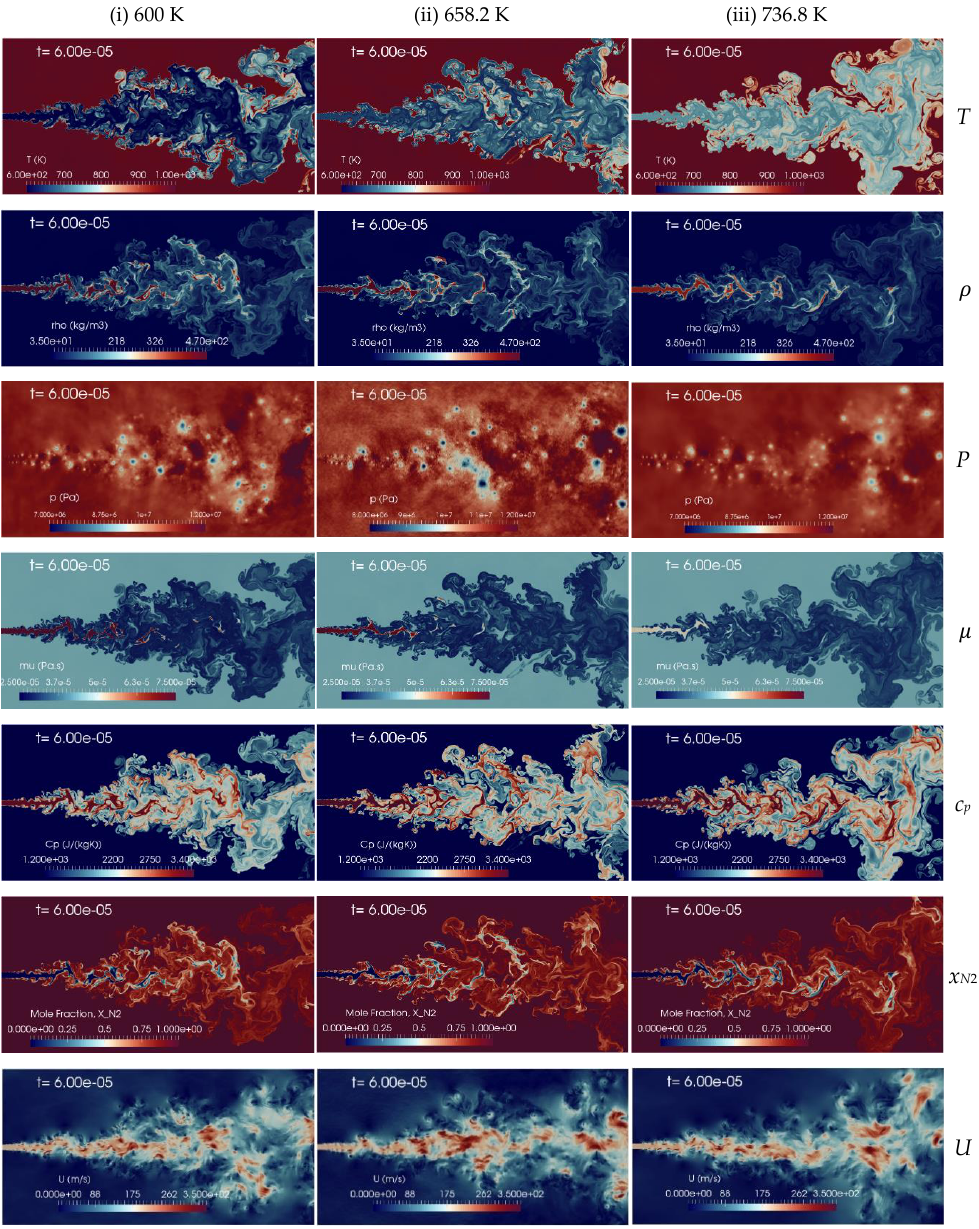
Figure 11. Instantaneous contour plots obtained from simulations of n-dodecane injected at 200 m/s into a supercritical hot nitrogen, 972.9 K and 11.1 MPa, for various injection temperatures: first column 600 K, second column 658.2 K, third column 736.9 K. Rows, from top to bottom, show instantaneous fields of temperature T [K], density ρ [ kg/m 3 ], pressure p [Pa], dynamic viscosity µ [ Pa · s], specific heat at constant pressure c p [J / (kg K)], mole fraction of nitrogen x N 2 [-], and velocity u [m /